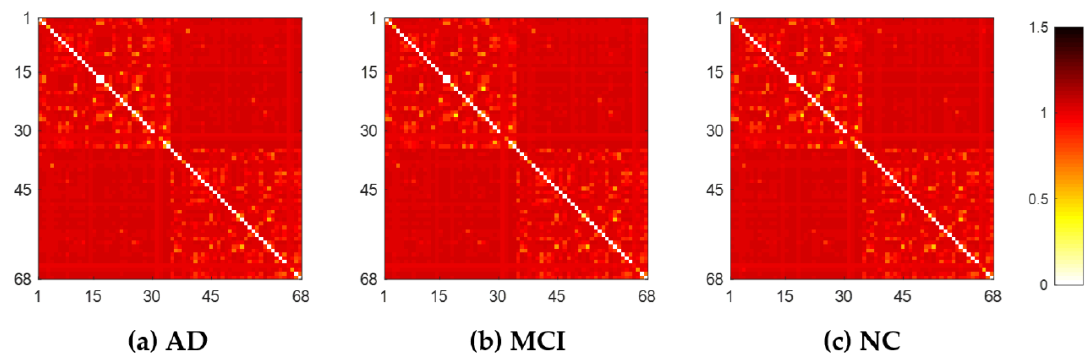
Figure 1. The original weighted white matter (WM) networks of the three groups, AD ( a ), MCI ( b ), and NC ( c ), where color bar shows the weights between any pair of region-of-interests (ROIs).